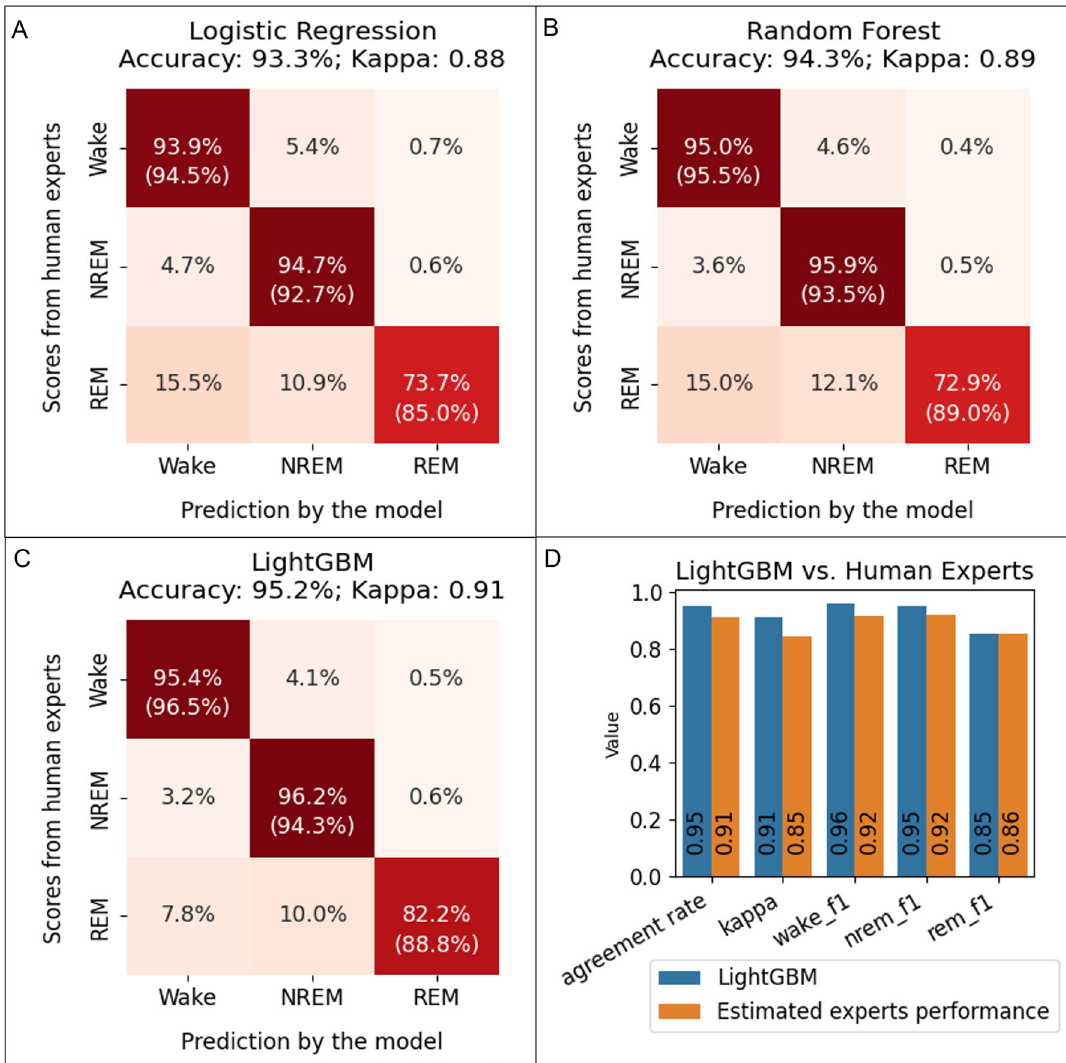
Figure 3. Comparisons between the baseline models (logistic regression and random forest), the LightGBM model, and human experts. ( A – C ): the performance of the logistic regression, the random forest model, and the LightGBM model. The numbers without parentheses in the heatmaps indicate the percentage of the scores from human experts (ground truth) that are in agreement with the scores generated by the model. The numbers inside parentheses indicate the percentage of model-generated scores that are in agreement with the scores of the human experts. Therefore, in the left–right diagonal line, the numbers without parentheses indicate recall, and the numbers inside parentheses indicate precision. ( D ) Comparisons of the accuracy, kappa, wake f1-score, NREM f1-score, and REM f1-score between the LightGBM model and human experts. The performance of human experts was estimated using the scores provided by two human experts from different labs from a publicly available